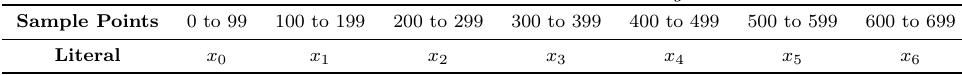
Table 4: Sample points for each literals of TTSCA big on ASCADv1_f. Sample